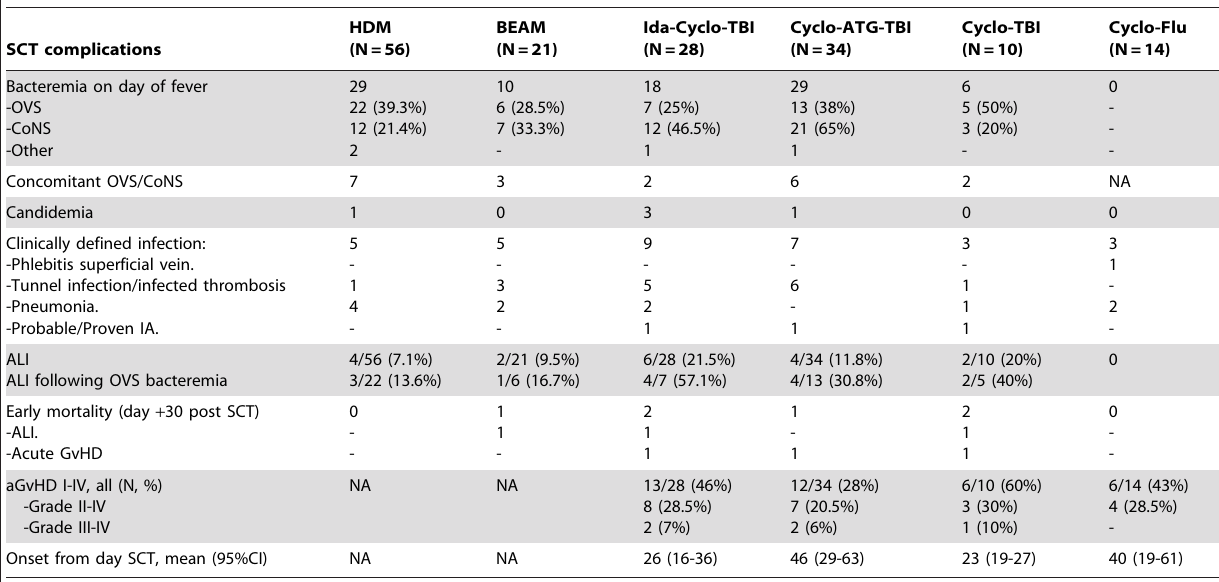
Table 3. Stem cell transplantation